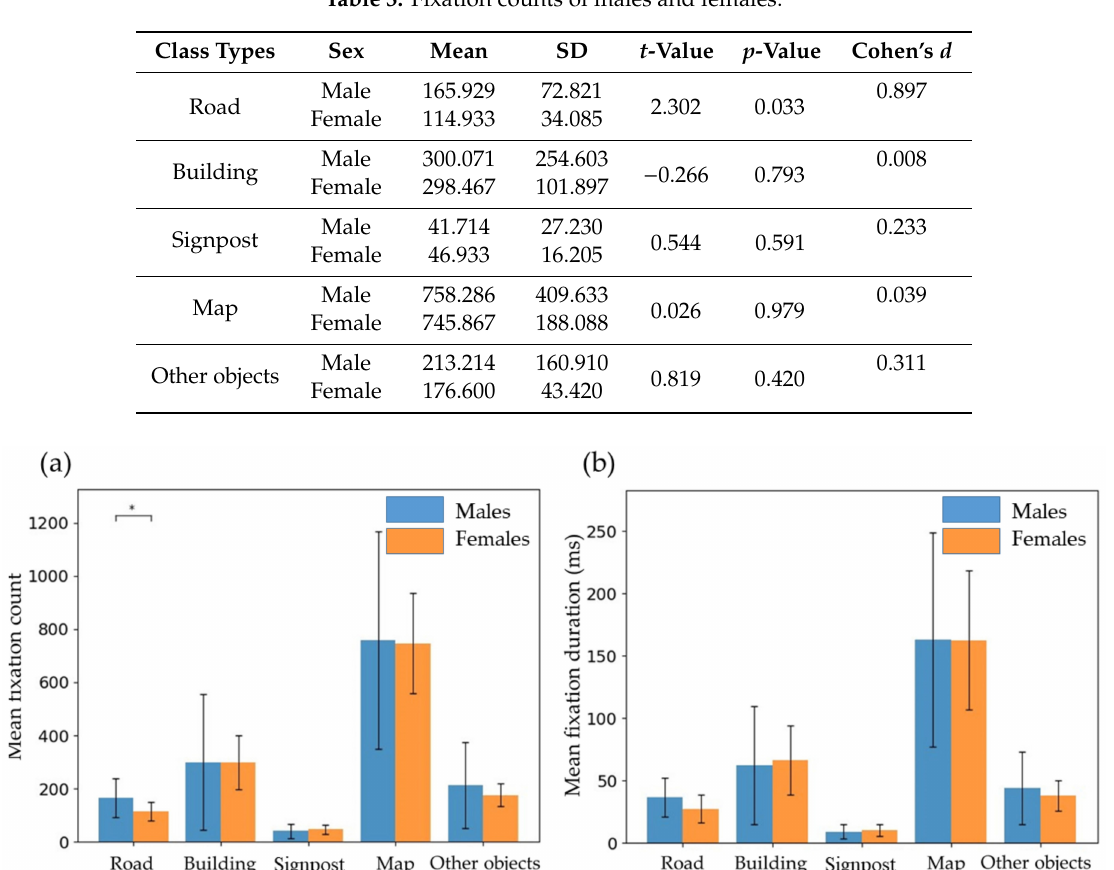
Figure 4. Comparison of the ( a ) mean fixation count and ( b ) mean fixation duration among the five